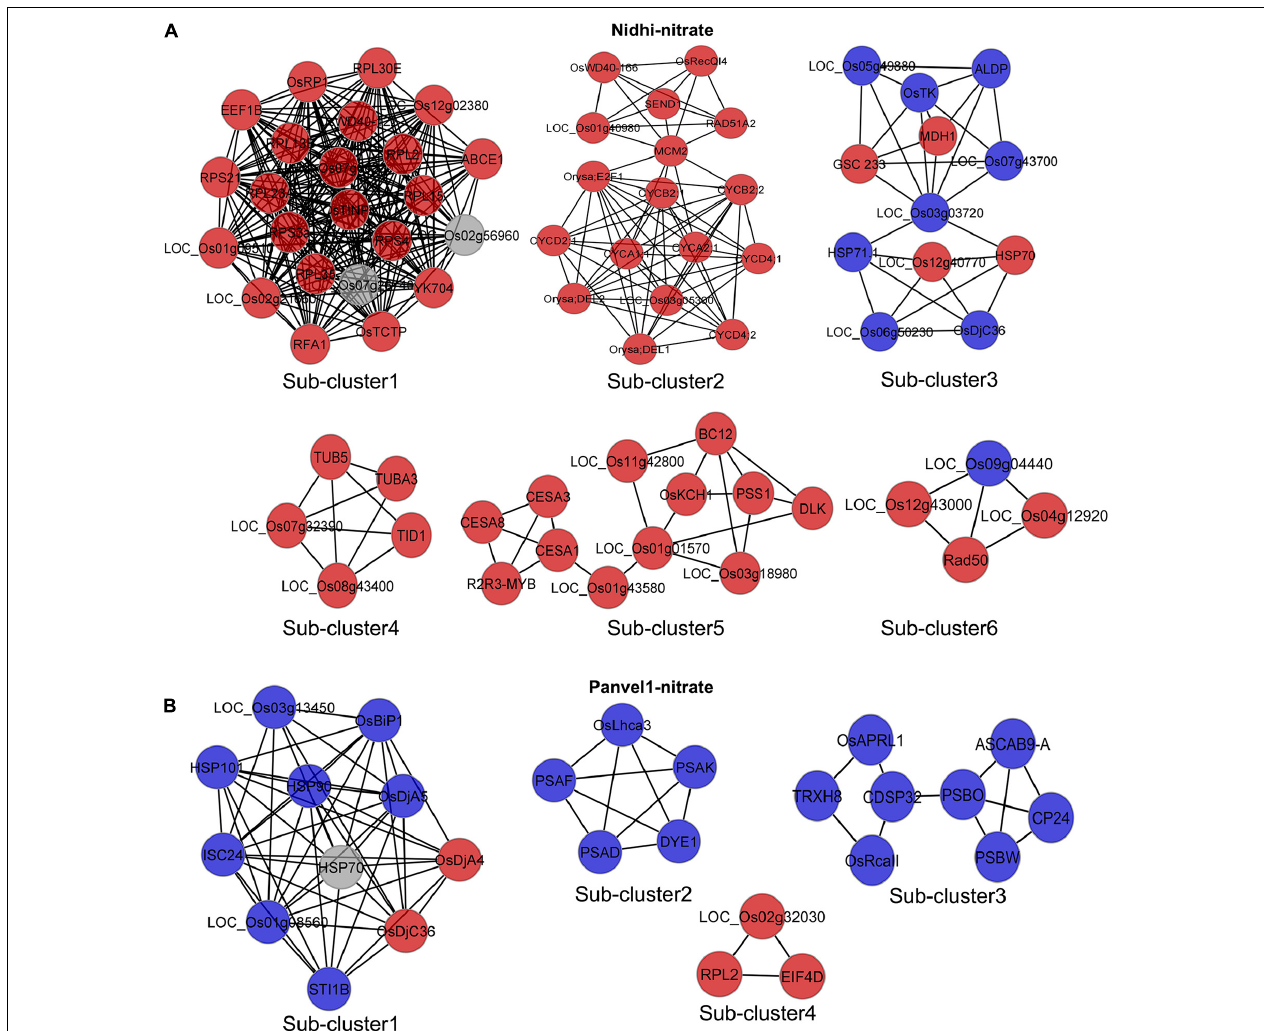
FIGURE 6 | Nitrate-responsive protein-protein interaction (PPI) sub-clusters/molecular complexes in Nidhi and Panvel1. DEGs-associated interactors were retrieved by STRING, BioGRID, PRIN, and MCDRP databases. Experimentally validated interaction pairs were used to construct the PPI networks in Cytoscape ( Supplementary Figures S2, S3 ). Molecular complexes/sub-clusters of PPI networks were identified using the MCODE plugin in Cytoscape. Thirteen and six sub-clusters/molecular complexes were detected in Nidhi and Panvel1, respectively. Important nitrate-responsive sub-clusters/molecular complexes identified in Nidhi and Panvel1 are shown (A,B) and the remaining are given in Supplementary Figure S4 . Red and blue color nodes correspond to the up and downregulated DEGs, respectively. Light gray color nodes represent the interactors, which are not DEGs.